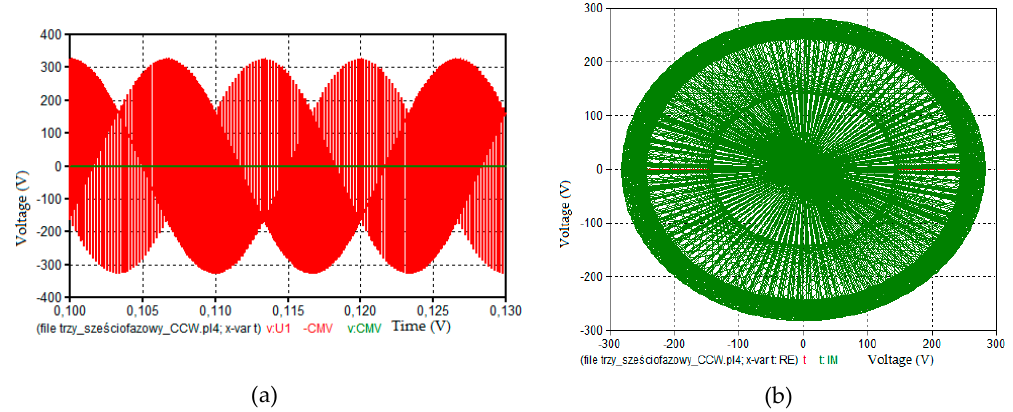
Figure 5. Waveforms of the output voltages (red lines) and the CMV (green lines) ( a ) and trajectory of the output voltage ( b ), synthesized in the MC controlled by the use of the CCW rotating space vectors, for six ‐ phase load and output frequency of 30 Hz.